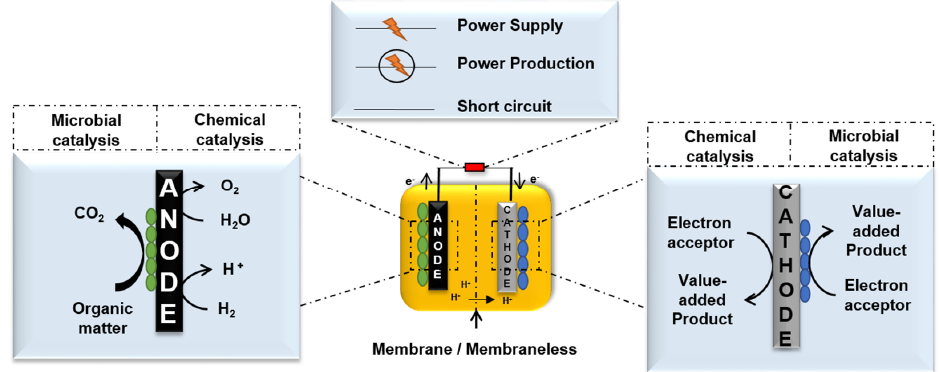
Figure 3. An in-depth overview of the concepts associated with the highly versatile microbe–electrode interaction-based microbial BES technology and a multitude of choices available to carry out a diverse range of processes at both anodic and cathodic chambers simultaneously [43].